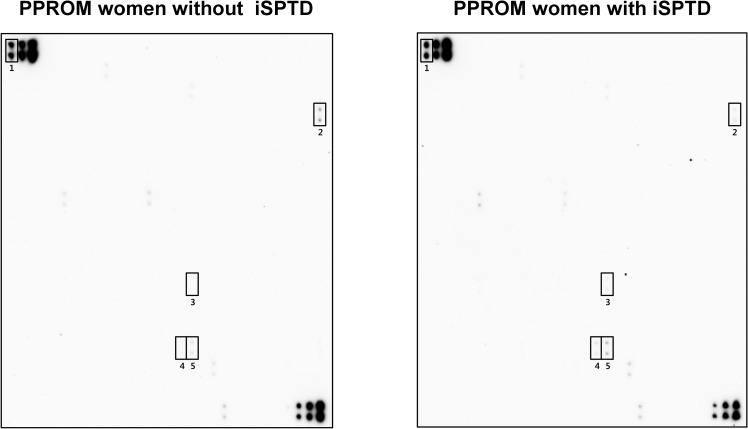
Expression levels of 507 inflammatory and immunoregulatory proteins in amniotic fluid (AF) from women with preterm premature rupture of membranes (PPROM), comparing the imminent spontaneous preterm delivery (iSPTD) and non-imminent SPTD groups.The pooled AF samples in each group (15 women with iSPTD, 15 gestational age-matched women without iSPTD) were assayed using a human antibody array kit (AAH-BLM-1B-2; RayBiotech, Norcross, GA). Using cut-off values of fold change of ≥ 1.5 or ≤ 0.66 for upregulated or downregulated proteins, 4 differentially regulated proteins in AF samples from women with iSPTD relative to women without iSPTD are indicated in rectangles. Number 1 shows the positive controls.